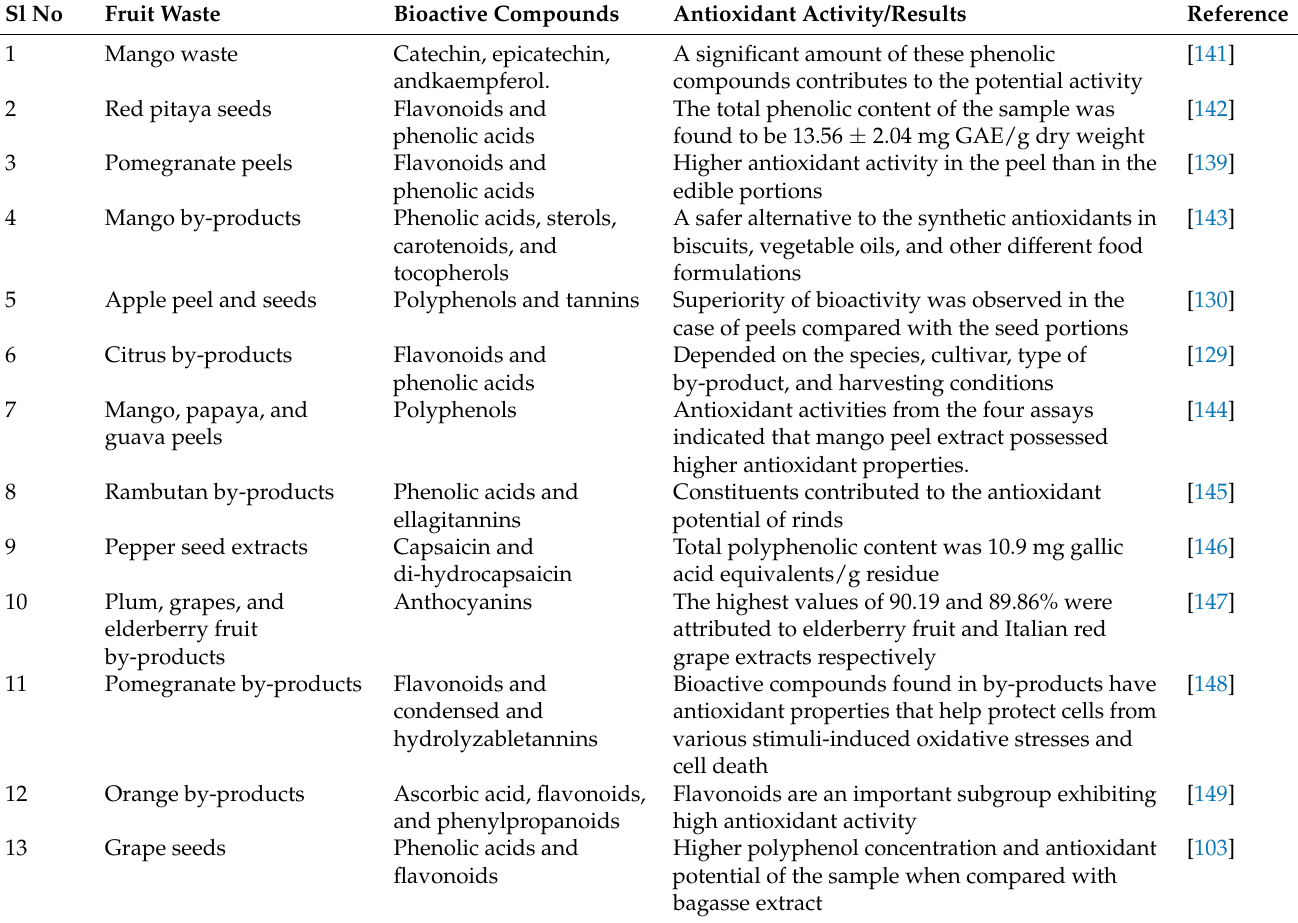
Table 2. Antioxidant activities of bioactive compounds extracted from various fruit